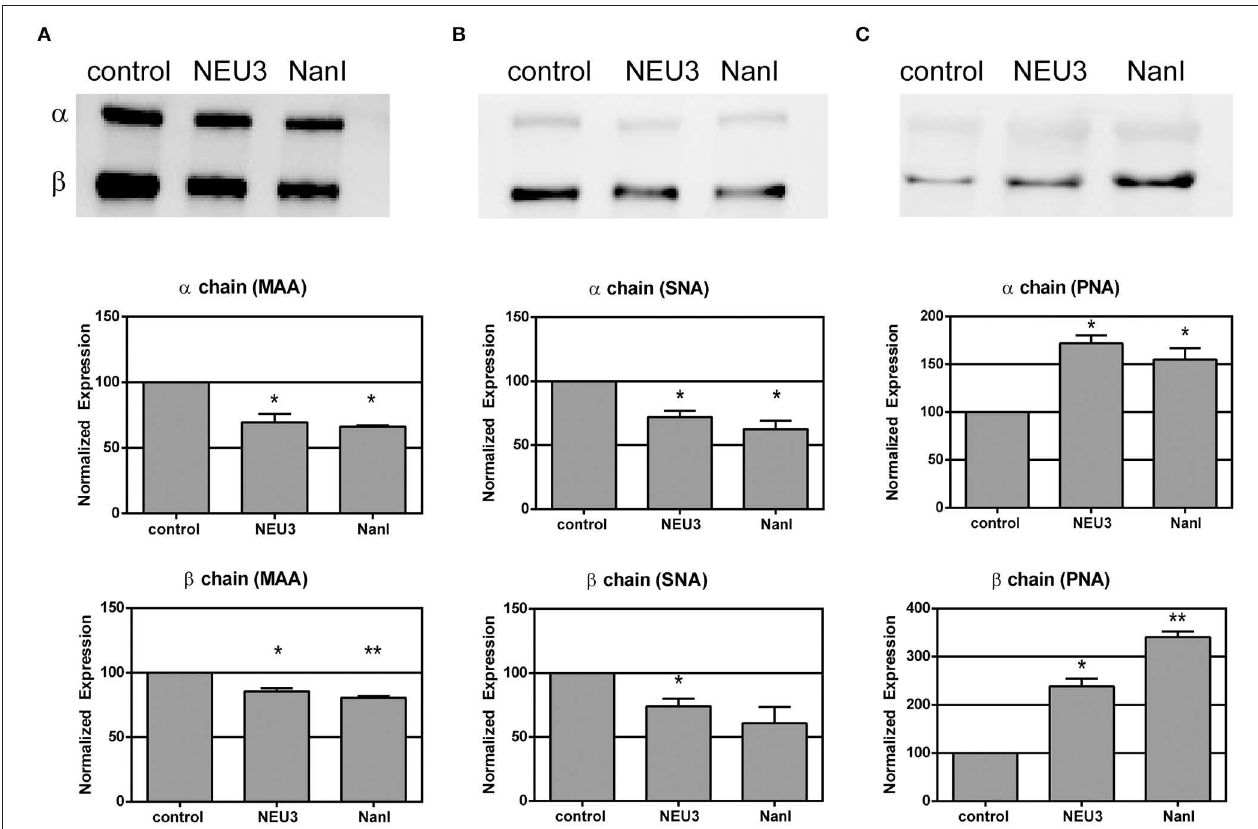
FIGURE 2 | Lectin blotting of LFA-1 shows sensitivity of LFA-1 to NEU treatment. Purified LFA-1 was treated with NEU3 and NanI for 3h at 37 ◦ C. The protein was then blotted and probed with biotinylated lectins. Lectins (A) MAA, (B) SNA, and (C) PNA were used. MAA and SNA recognize terminal sialic acid residues, while PNA recognizes terminal galactose residues. Chemiluminescent blots were developed and analyzed for changes in band intensities, and a representative image from two experiments are shown at the top of each panel (see Supporting Information ). Data are shown as the mean ± SEM and were compared to the appropriate control